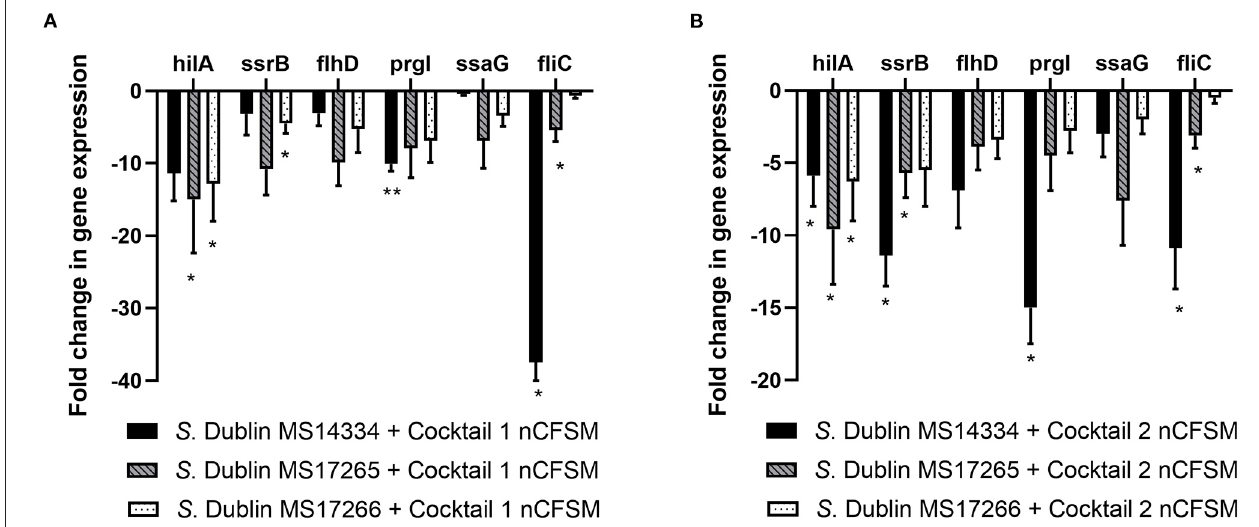
FIGURE 7 | Effect of nCFSM from (A) cocktail 1 and (B) cocktail 2 on virulence gene expression in 3 S. Dublin strain. The expression data were normalized to validated reference gene gapA and presented as fold change of expression levels in nCFSM relative to non-fermented milk. Three independent replicates including two technical replicates each were performed. The data shown represents the mean and the error bars represent standard deviations. The stars indicate statistical significance at different levels: * P ≤ 0.05, ** P ≤